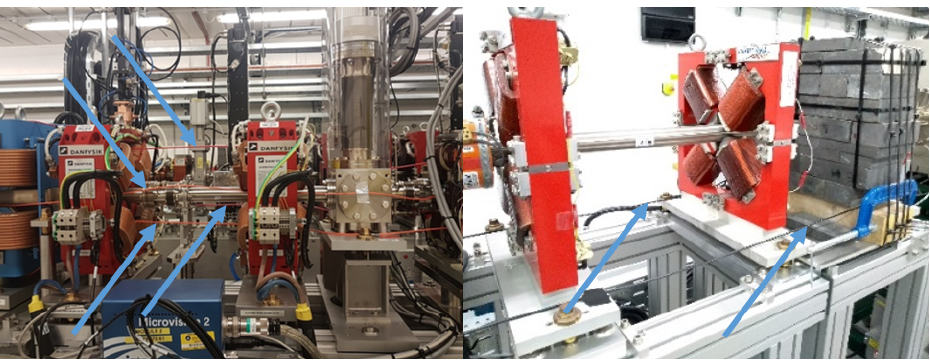
Figure 2. Left : optical fibre woven through the electromagnetic elements of a beamline (fibre in orange). Right : optical fibre running parallel to a beamline but outside of any machine elements (fibre in black). Fibres are indicated by blue arrows for clarity.